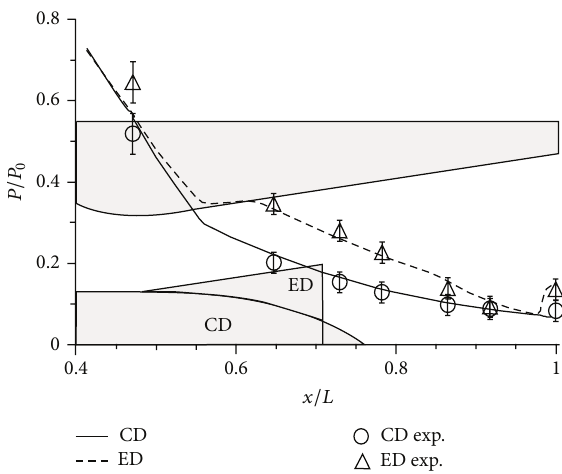
Figure 13: Comparison of pressure distributions in the OX condi-